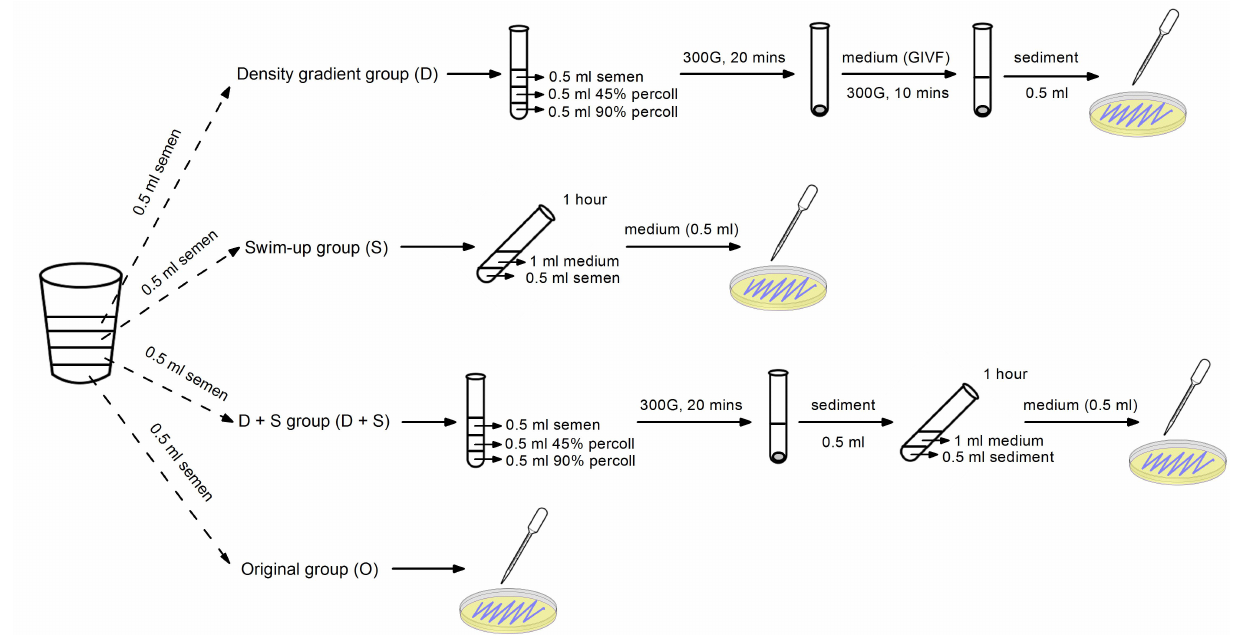
Fig. 1. Workflow diagram. Diagrammatic semen preparation protocols.